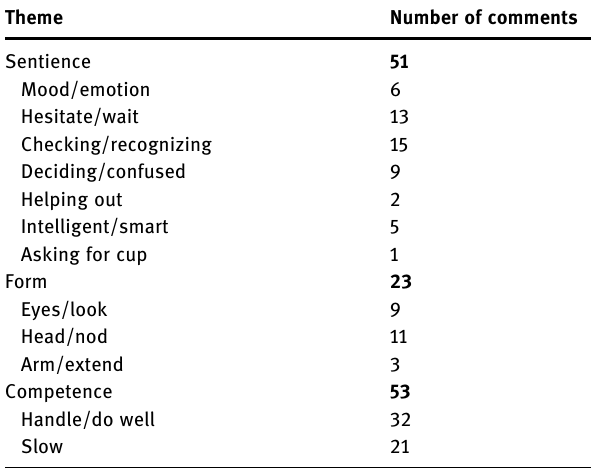
Table 2: Themes and underlying codes and number of comments regarding Fetch ’ s movement; bold indicates the theme and the total number of all its